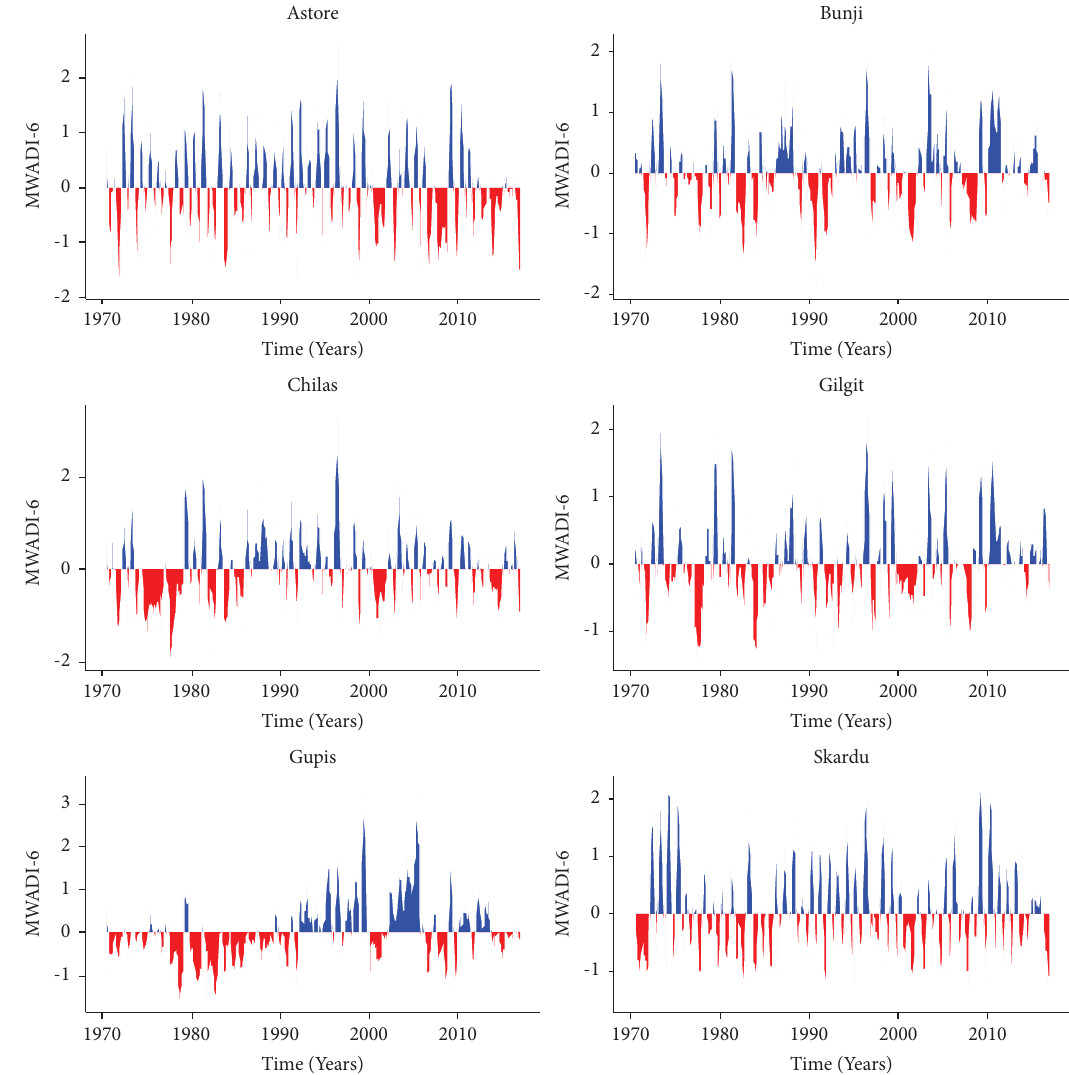
Figure 11: Temporal behavior of the MWADI at 6-month time scale at all